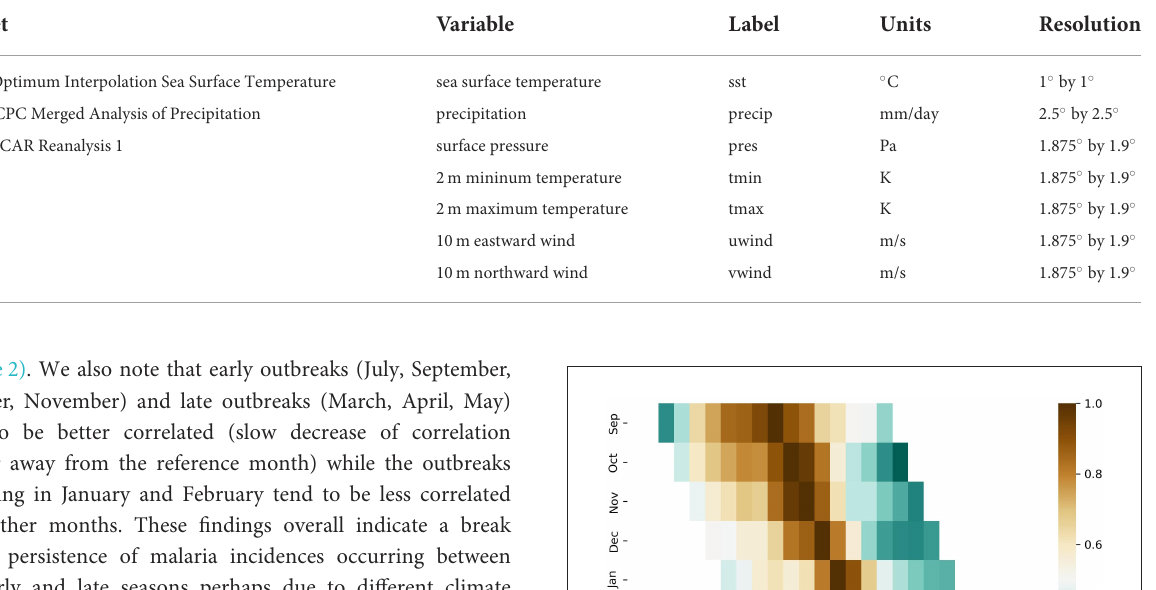
TABLE 1 List of climate variables with their origin, units, and spatial resolution.